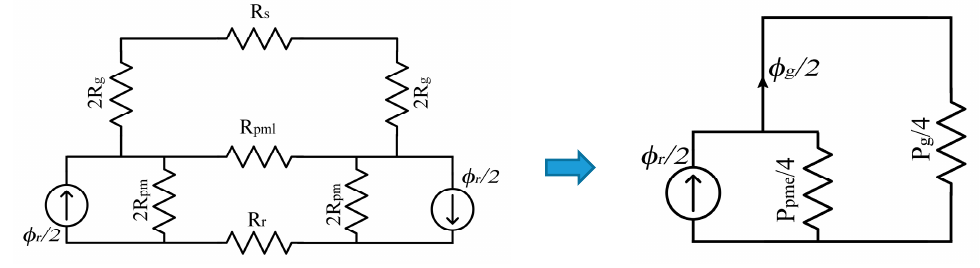
Figure 4. The simplified MAGEC.